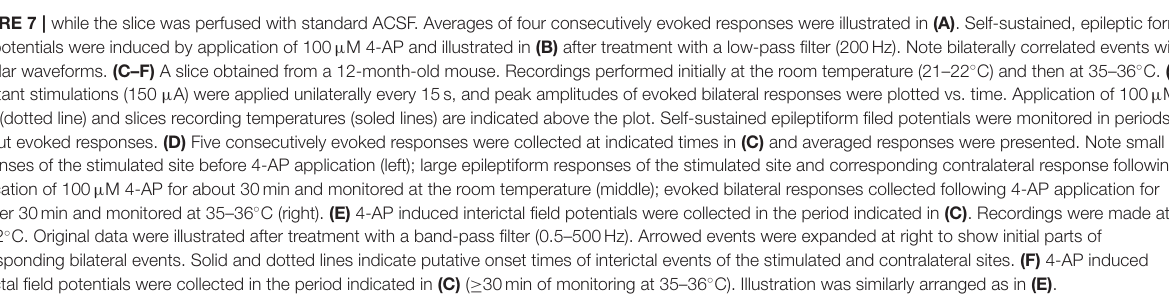
FIGURE 7 | while the slice was perfused with standard ACSF. Averages of four consecutively evoked responses were illustrated in (A) . Self-sustained, epileptic form field potentials were induced by application of 100 µ M 4-AP and illustrated in (B) after treatment with a low-pass filter (200Hz). Note bilaterally correlated events with irregular waveforms. (C–F) A slice obtained from a 12-month-old mouse. Recordings performed initially at the room temperature (21–22 ◦ C) and then at 35–36 ◦ C. (C) Constant stimulations (150 µ A) were applied unilaterally every 15s, and peak amplitudes of evoked bilateral responses were plotted vs. time. Application of 100 µ M 4-AP (dotted line) and slices recording temperatures (soled lines) are indicated above the plot. Self-sustained epileptiform filed potentials were monitored in periods without evoked responses. (D) Five consecutively evoked responses were collected at indicated times in (C) and averaged responses were presented. Note small responses of the stimulated site before 4-AP application (left); large epileptiform responses of the stimulated site and corresponding contralateral response following application of 100 µ M 4-AP for about 30min and monitored at the room temperature (middle); evoked bilateral responses collected following 4-AP application for another 30min and monitored at 35–36 ◦ C (right). (E) 4-AP induced interictal field potentials were collected in the period indicated in (C) . Recordings were made at 21–22 ◦ C. Original data were illustrated after treatment with a band-pass filter (0.5–500Hz). Arrowed events were expanded at right to show initial parts of corresponding bilateral events. Solid and dotted lines indicate putative onset times of interictal events of the stimulated and contralateral sites. (F) 4-AP induced interictal field potentials were collected in the period indicated in (C) ( ≥ 30min of monitoring at 35–36 ◦ C). Illustration was similarly arranged as in (E)